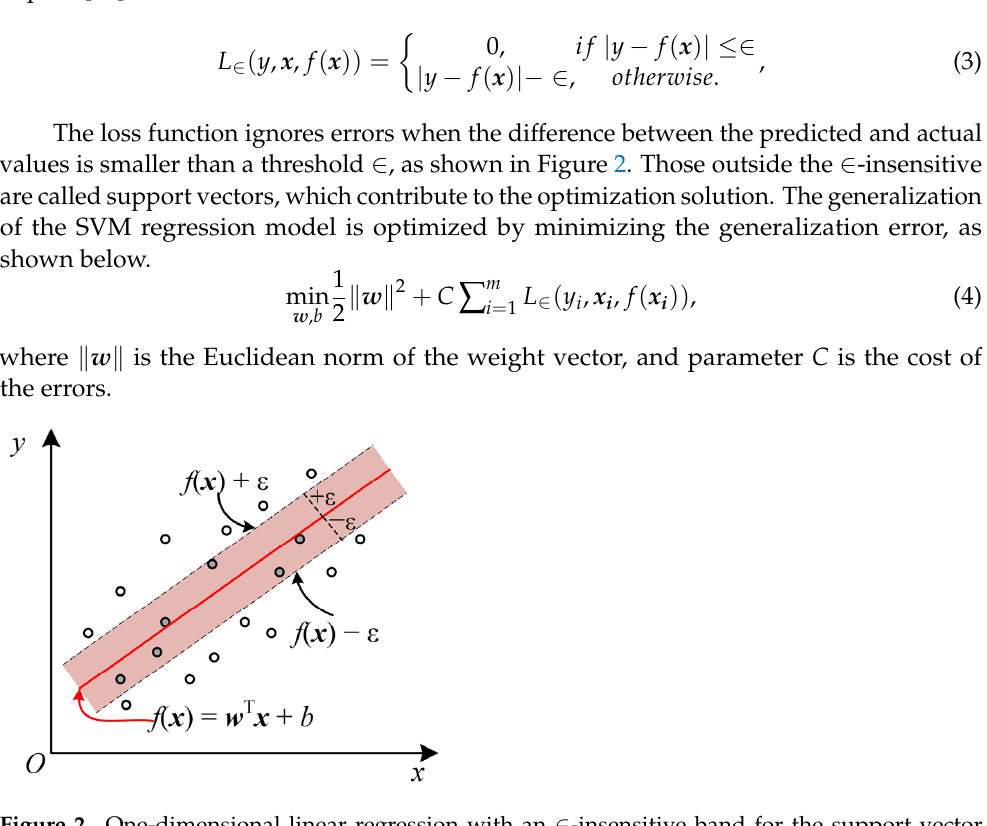
Figure 2. One-dimensional linear regression with an ∈ -insensitive band for the support vector machine (SVM) learning method.